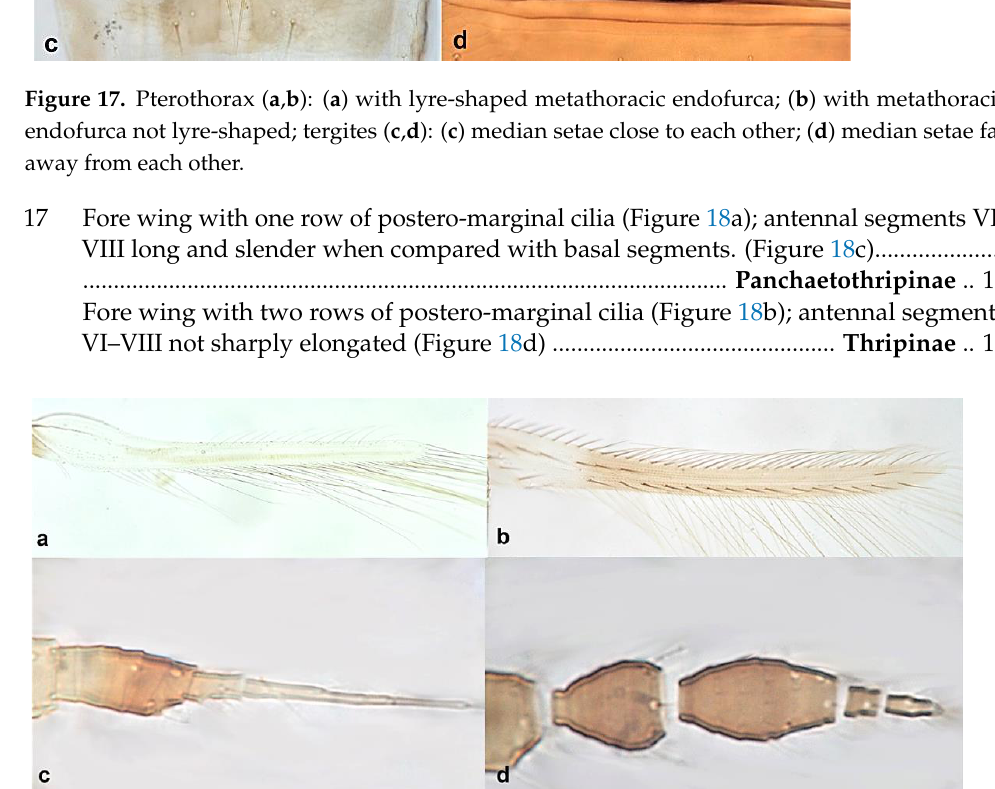
Figure 18. Fore wing ( a , b ): ( a ) one row of postero-marginal cilia; ( b ) two rows of postero-marginal cilia; terminal antennal segments ( c , d ): ( c ) ending in a sharp point; ( d ) not ending in a sharp point. 18 Fore tarsi one-segmented (Figure 19a); fore wings uniformly light brown; postero- marginal cilia straight (Figure 19c); fore wing apex rounded (Figure 19c)